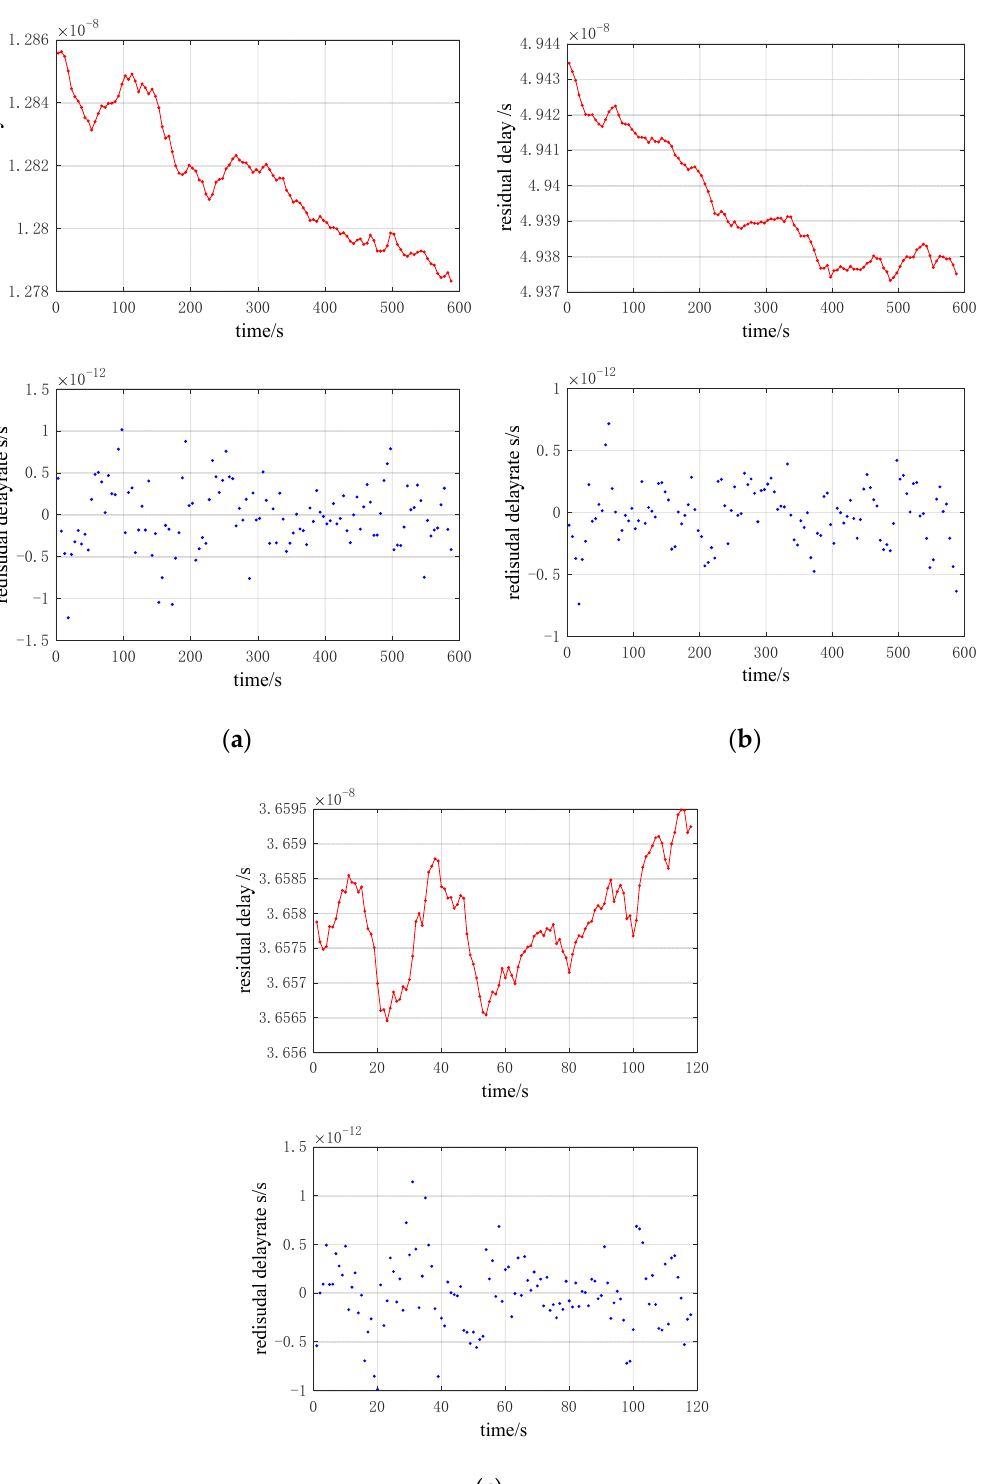
Figure 15. Residual delay and delay rate: ( a ) Baseline CEB ‐ NNO; ( b ) Baseline CEB ‐ KSH. ( c ) Baseline NNO ‐ KSH.